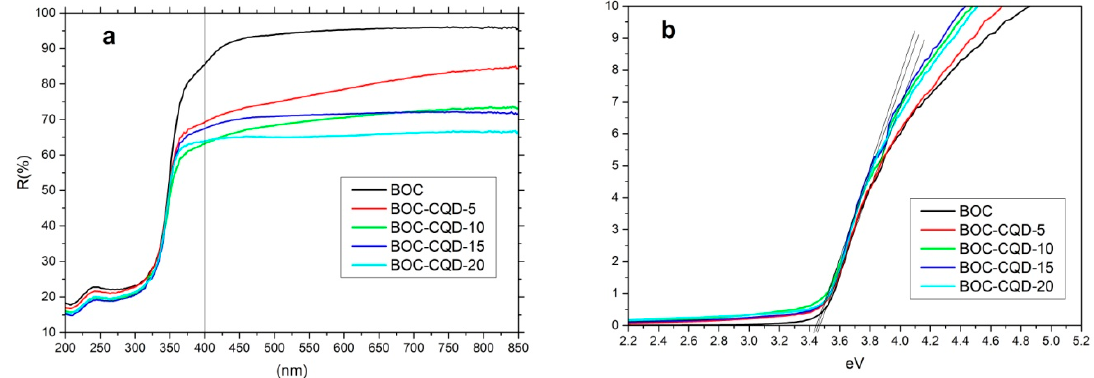
Figure 7. UV-Vis di ff use reflectance spectra of as-prepared samples ( a ) and band gap fitting with Figure 7. UV-Vis diffuse reflectance spectra of as-prepared samples ( a ) and band gap fitting with KMrelation ( b KMrelation ( b ).